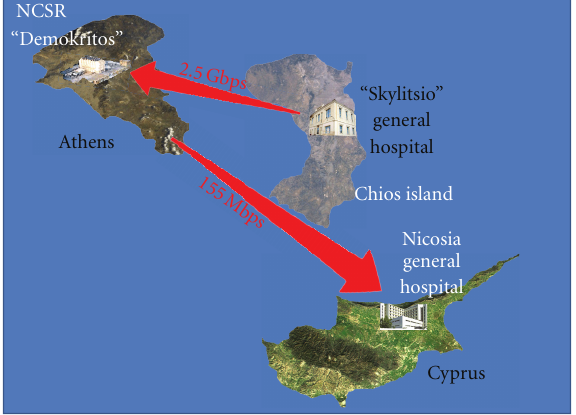
Figure 1: Tile-Ippokratis pilot